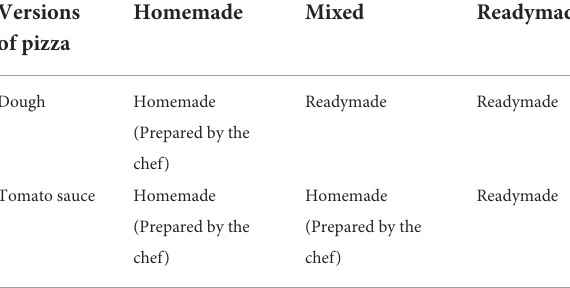
TABLE 1 Description of the main differences among the three versions of